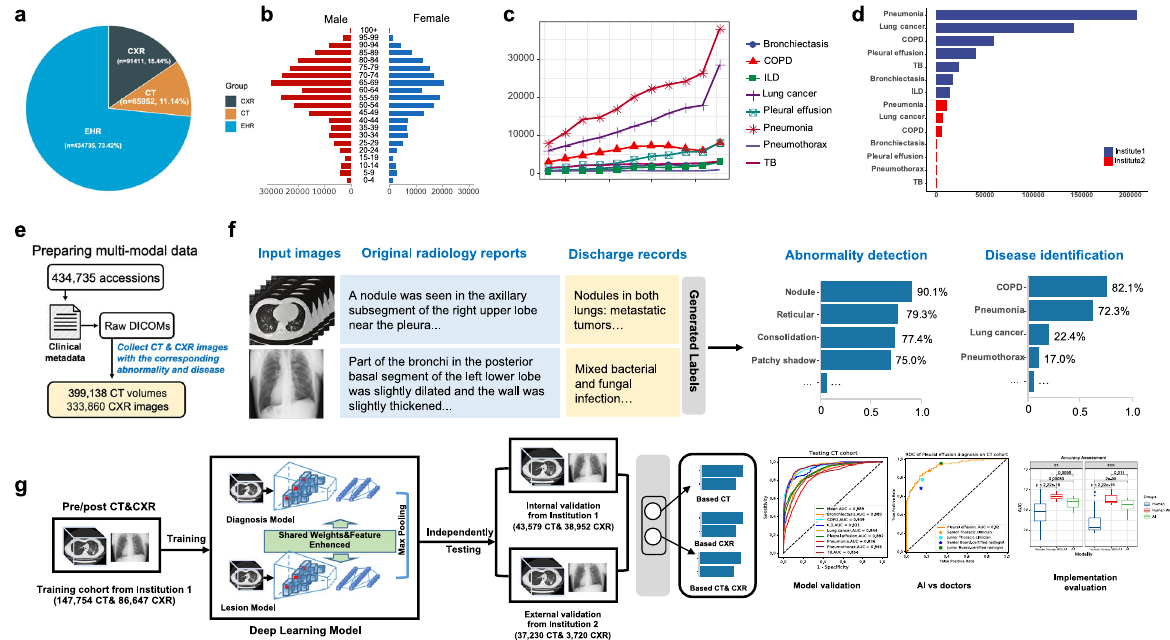
Fig. 1 Overview of the framework for developing deep learning models. a Initial cohort consists of an EHR dataset and radiograph dataset to develop an NLP algorithm and the deep learning-based algorithm. b Patients ’ sex and age distribution. c The annual occurrence rates of eight major respiratory diseases. d Patients ’ disease distribution from the two distinct hospitals. e Strategy for data collection. f NLP model that automatically extracted labels from free-text radiology reports and discharge diagnosis records. g Development and validation of a deep learning system to predict 8 major respiratory diseases and 20 radiological abnormalities based on CT/CXR dataset. COPD chronic obstructive pulmonary disease, ILD interstitial lung disease, TB